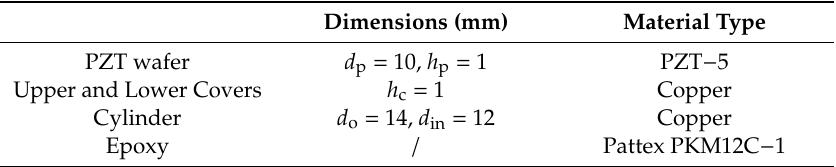
Table 1. The structural dimension and material type of PiSSA.